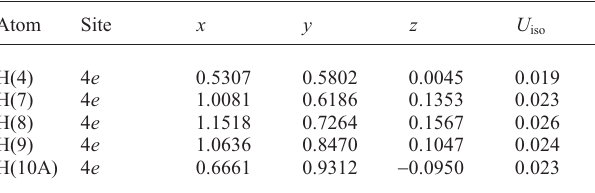
Table 2. Atomic coordinates and displacement parameters (in Å 2 ) .